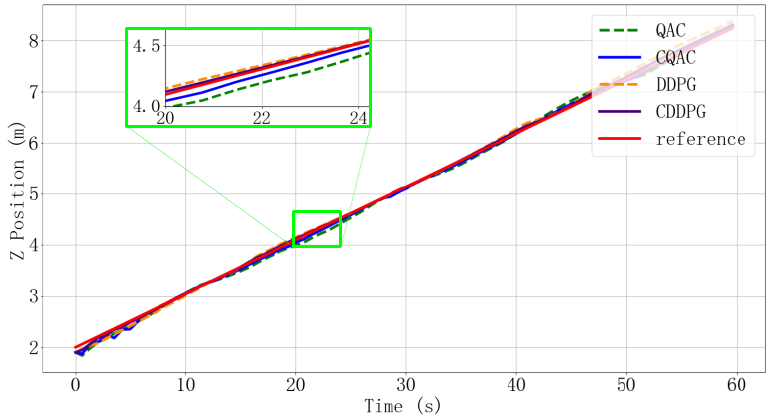
Figure 13. Tracking track of Z position.